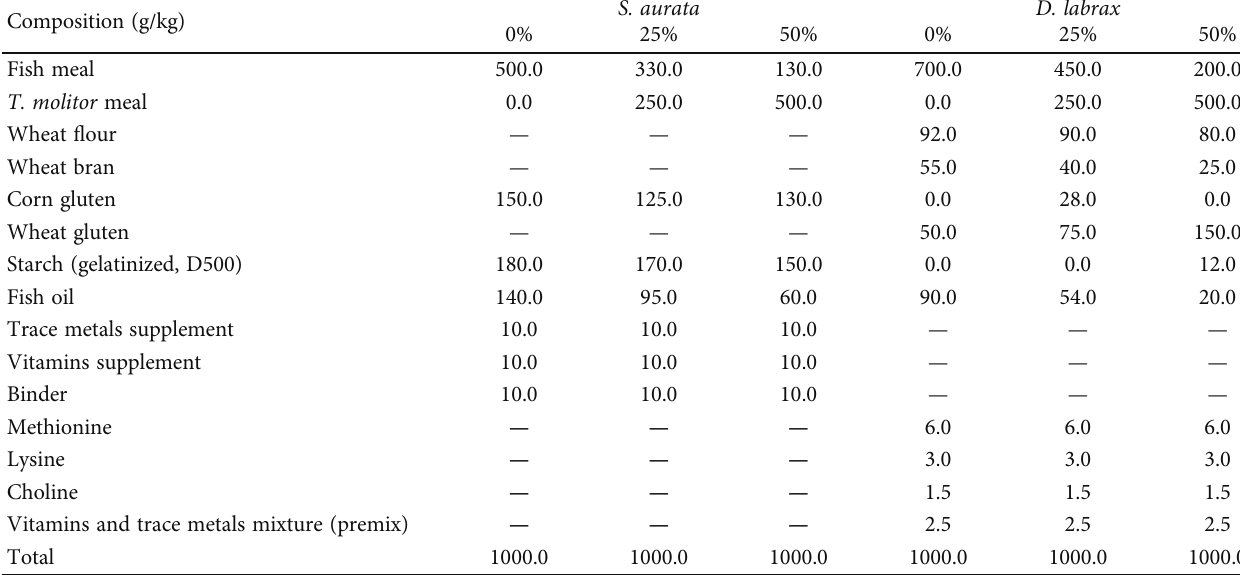
Table 1: Composition of the experimental